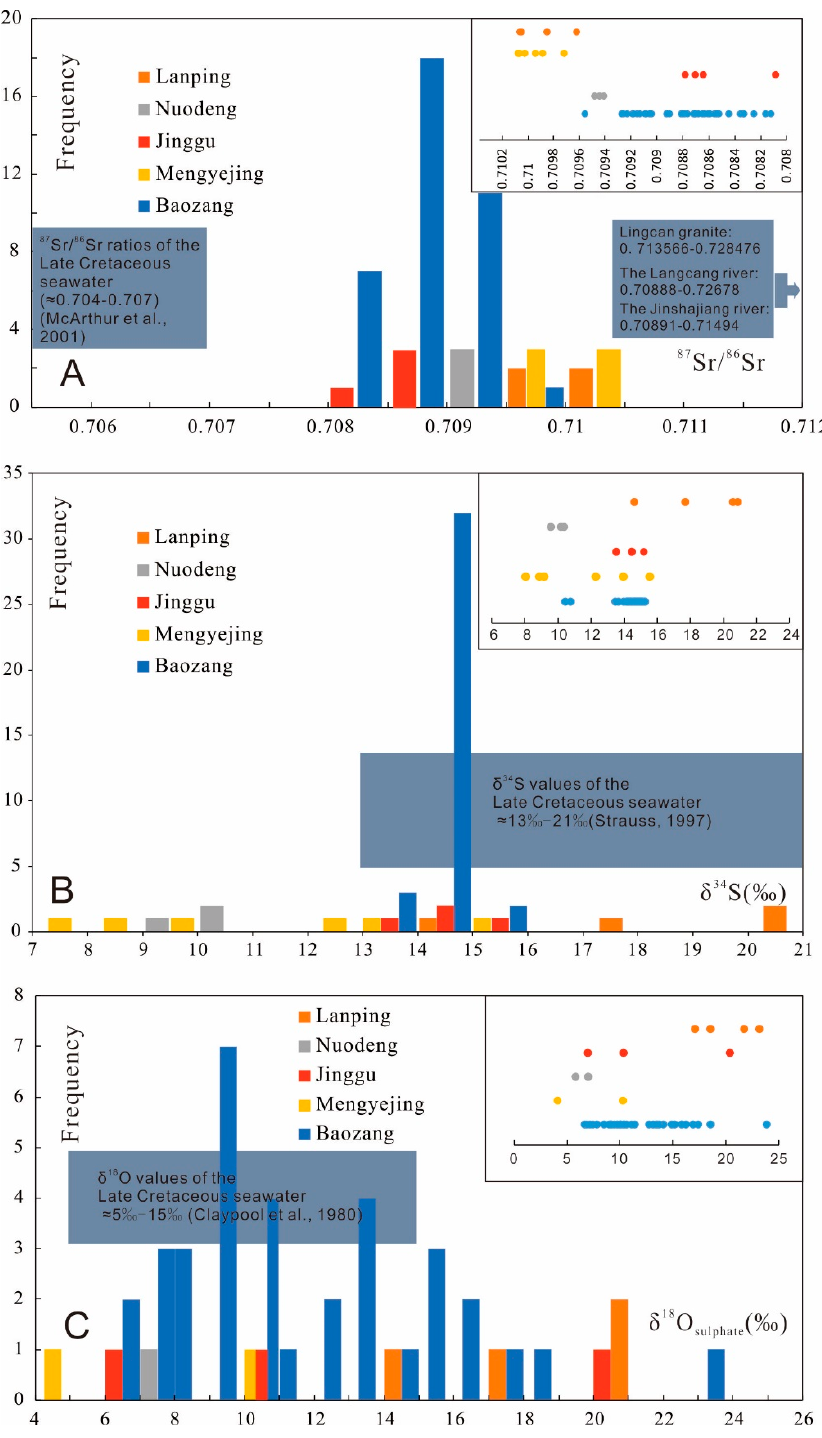
Figure 6. Histograms showing distribution of ( A ) 87 Sr/ 86 Sr ratios, ( B ) δ 34 S values, and ( C ) δ 18 O values in evaporitic minerals from the Lanping–Simao Basin.